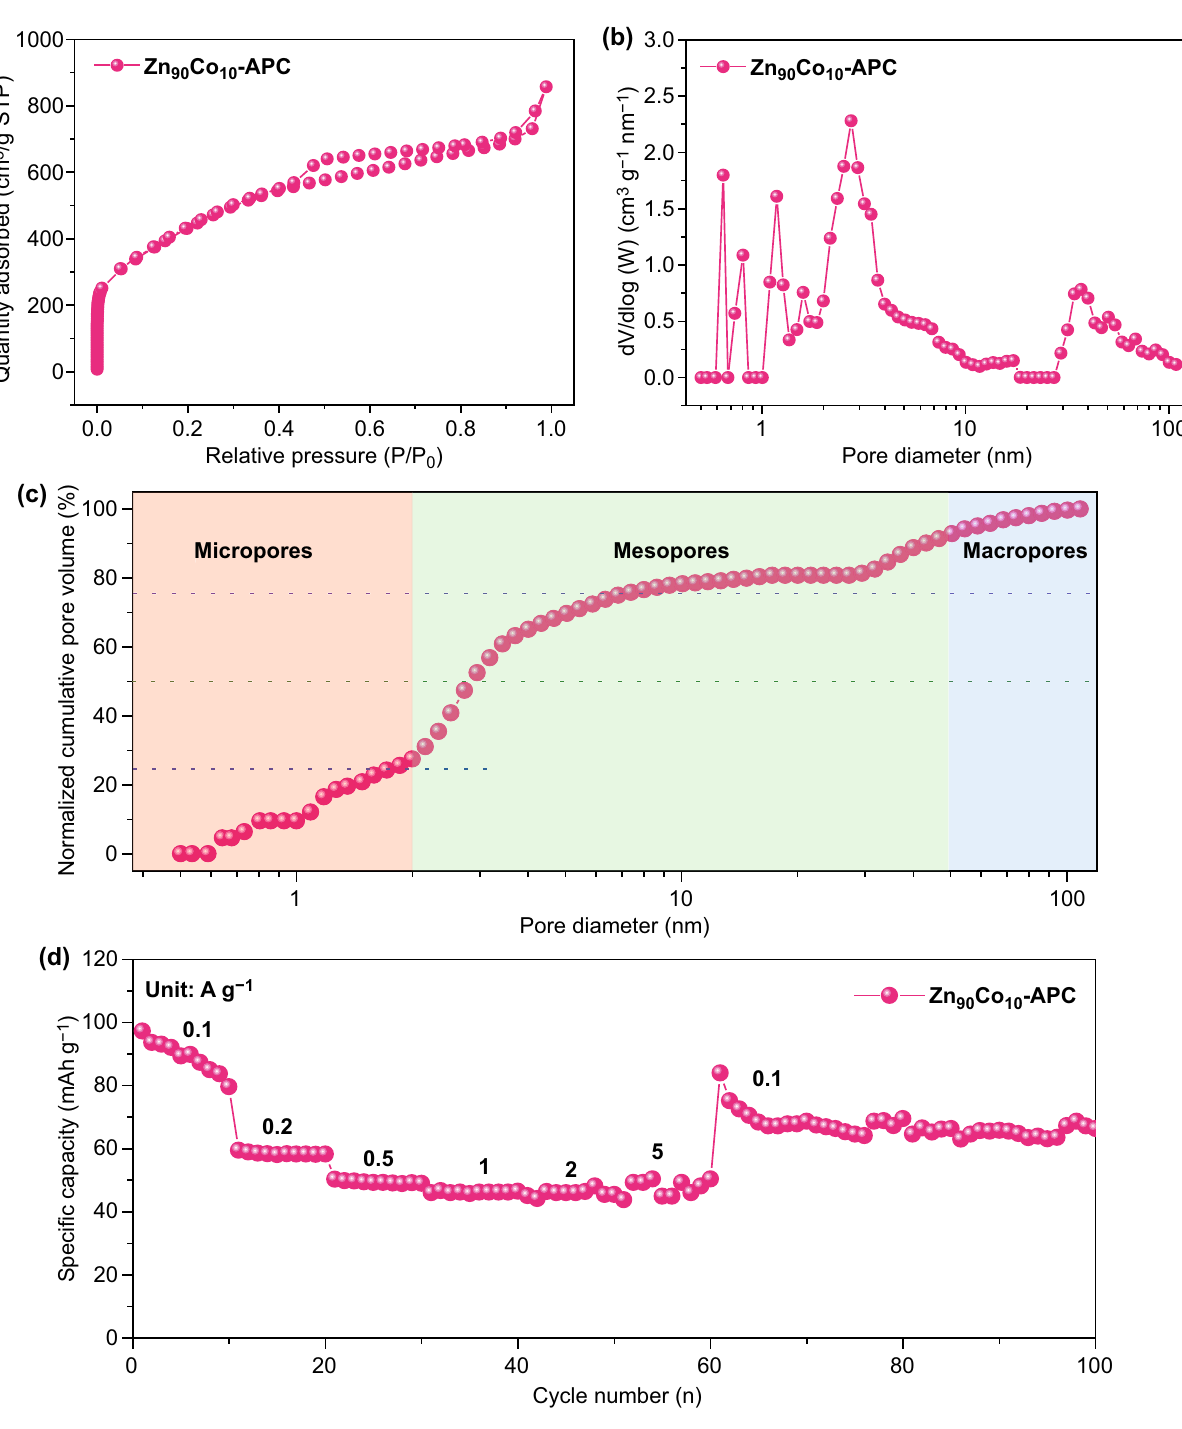
Fig. 8 a N 2 adsorption–desorption isotherms, b pore size distribution curves, c normalized cumulative pore size distributions and d rate capa‑ bilities of Zn 90 Co 10